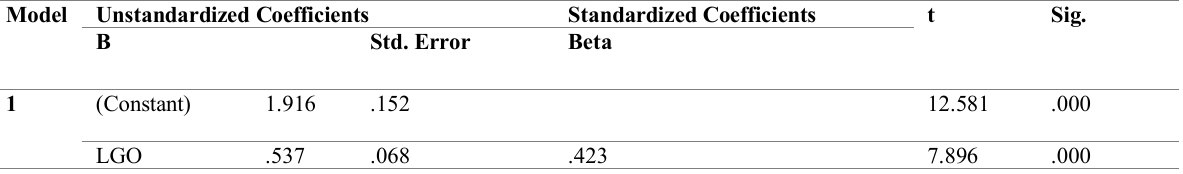
Table 5: Coefficient for Regression of LD against